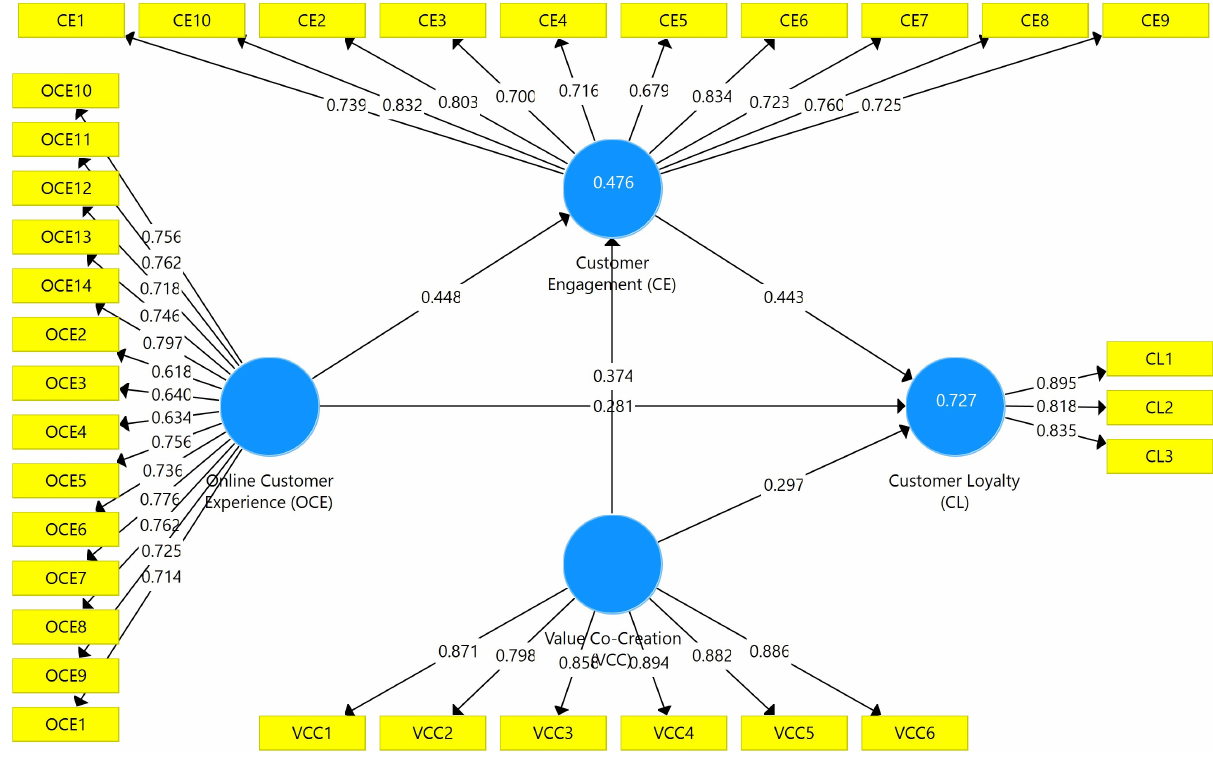
FIGURE 2 | Measurement